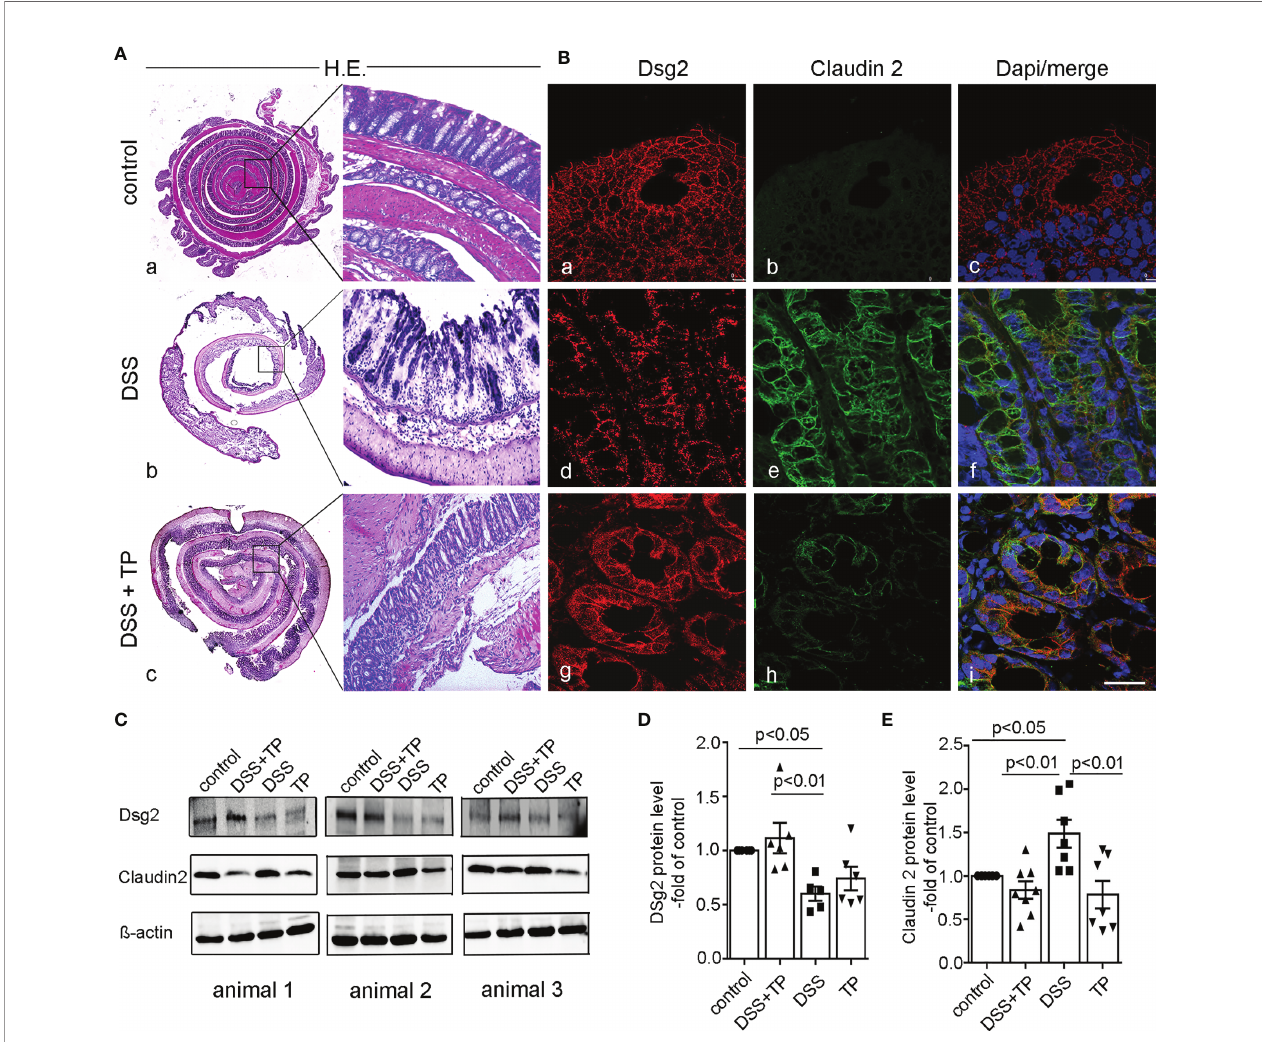
FIGURE 2 | TP affected DSS-induced redistribution of Dsg2 and Cld2 at the cell border in vivo . (A) Representative H&E staining of mouse colon are shown (left overview; right magni fi cation). Controls (a) show a normal morphology of the gut whereas DSS (2.5% DSS) animals (b) show signs of severe in fl ammation with mucosal damage. Treatment of animals with 10 µM TP (c; DSS+TP) attenuated in fl ammation-induced changes in the colon. Images shown are representatives for n=6 in each group. (B) Immunostaining for Dsg2 (a, d, g), Claudin2 (b, e, h) or merged images with staining of cell nuclei using DAPI (c, f, i) are shown for the same conditions. The loss of Dsg2 in DSS animals (d) compared to controls (a) is attenuated by TP treatment (g). This is paralleled by augmented Claudin2 staining (e) in DSS colitis compared to controls (b) whereas TP blocked in fl ammation-induced increase of Claudin2 (h). Images shown are representatives of n=6 in each group. Scale bar is 25 µm. (C) Western Blots from colon lysates of control animals, animals with DSS colitis treated with TP (DSS+TP), DSS colitis alone and with TP alone are shown for Dsg2 and Claudin2 and b -actin. A set of 3 different animals is shown. (D) Quantitative analyses of the optical densities for Dsg2 Western blot bands normalized to b -actin showed reduced Dsg2 compared to DSS-colitis. This reduction was not observed in DSS+TP-treated animals (p<0.05 compared to the control group, n=6; p<0.01 compared to DSS+TP-treated mice; TP showed no signi fi cant change compared to all other groups; n=6 for each group, ordinary 1-way ANOVA). (E) Quantitative analyses of the optical densities for Claudin2 Western Blot bands normalized to b -actin showed signi fi cantly increase of Claudin2 in DSS mice compared to control mice (p<0.05) which was blocked by TP (p<0.01) (n=6 for each group; ordinary one-way